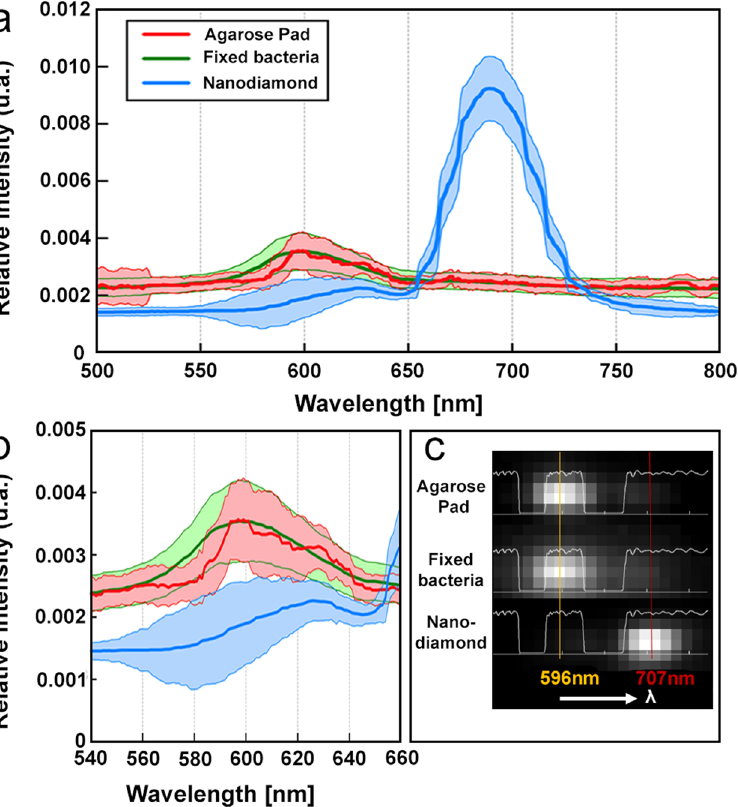
Figure 4. Single-molecule spectral imaging of molecules on the surface of the agarose pads (red), of autoblinking molecules in fixed D. radiodurans cells (green), and of nanodiamonds (blue). ( a ) Average emission spectra (500 nm to 825 nm) derived from 34, 1221 and 1013 individual spectra respectively. ( b ) Inset of ( a ) focusing on the 540 nm to 660 nm wavelength range. ( c ) Examples of raw spectra produced by molecules on the agarose pad, within fixed bacterial samples and by nanodiamonds. In light white is represented the Quad band notch spectrum used for the acquisition on the spectral